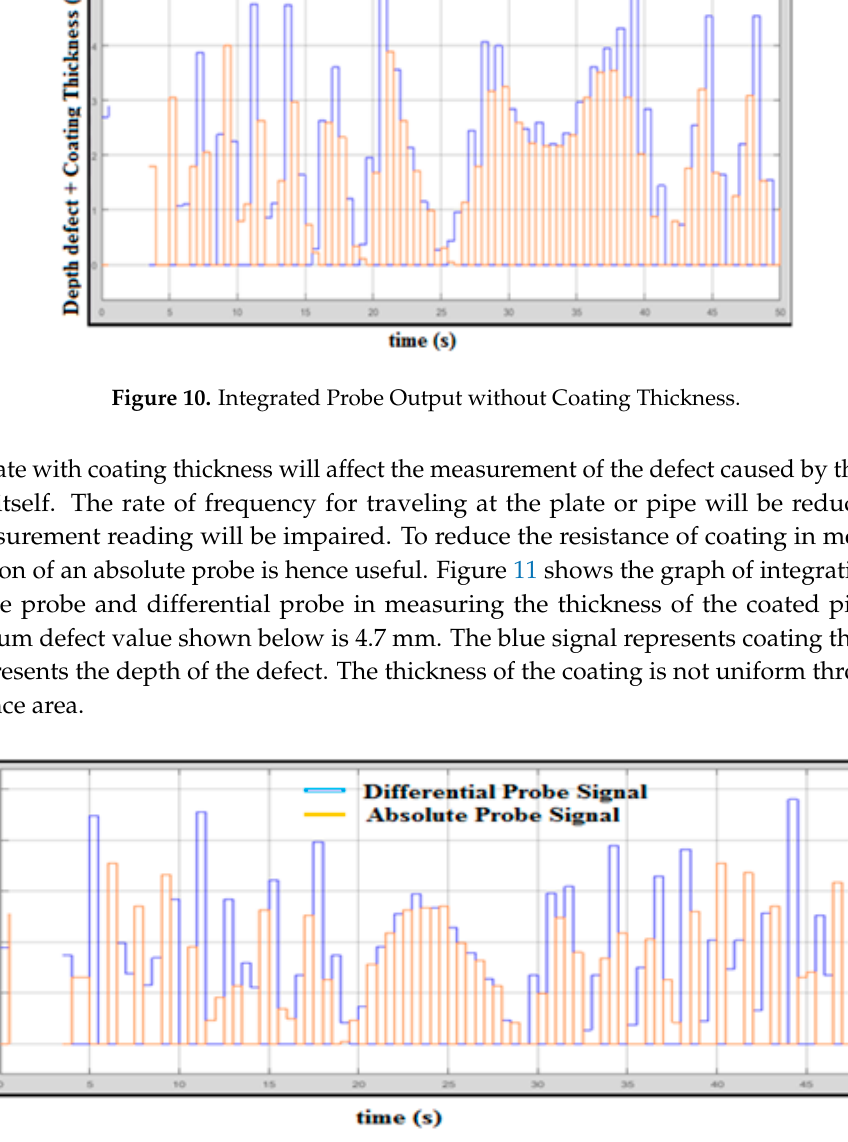
Figure 12. Fuzzy Logic for Error Compensation Signal Output without Coating Thickness. The difference between the coated and uncoated plate could be seen according to the signal produced during the inspection run. The conventional technique signals are slightly decreased from the actual value of the defect. The effect of the coated plate is shown in Figure 13, indicating the fuzzy logic for the error compensation of the signal output with coating thickness (lift-off). The maximum